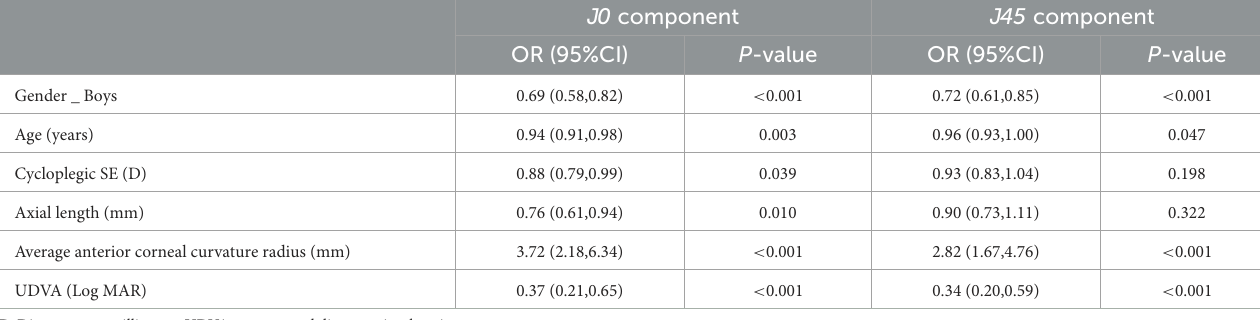
TABLE 4 Effect of full compensation on total astigmatism and uncorrected distance visual acuity based on multivariate Generalized Linear Model.